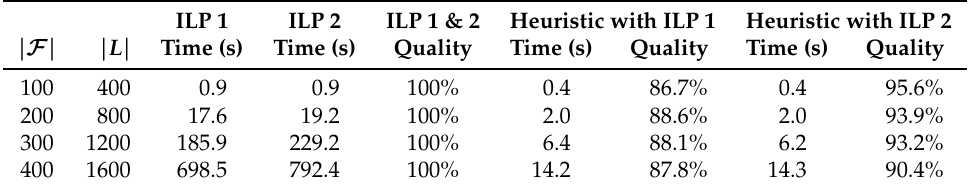
Table 3. Experimental results for instances with different numbers of points in a constant-sized area of size 10 × 10 and four labels of size 1.0 × 0.5 for each point. Every square of size 1 × 1 was required to intersect at most two labels. Running times are in seconds CPU time. Every value is an average over ten instances.